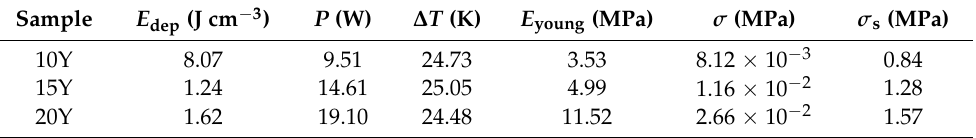
Table 4. Results of the thermo-mechanical